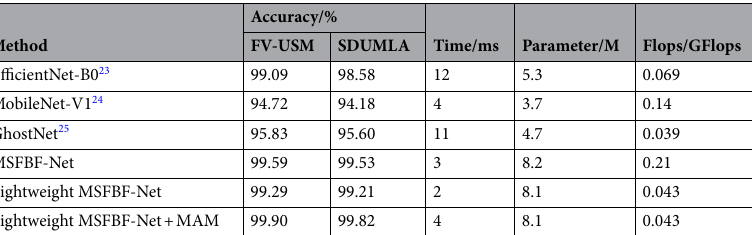
Table 3. Ablation experiment